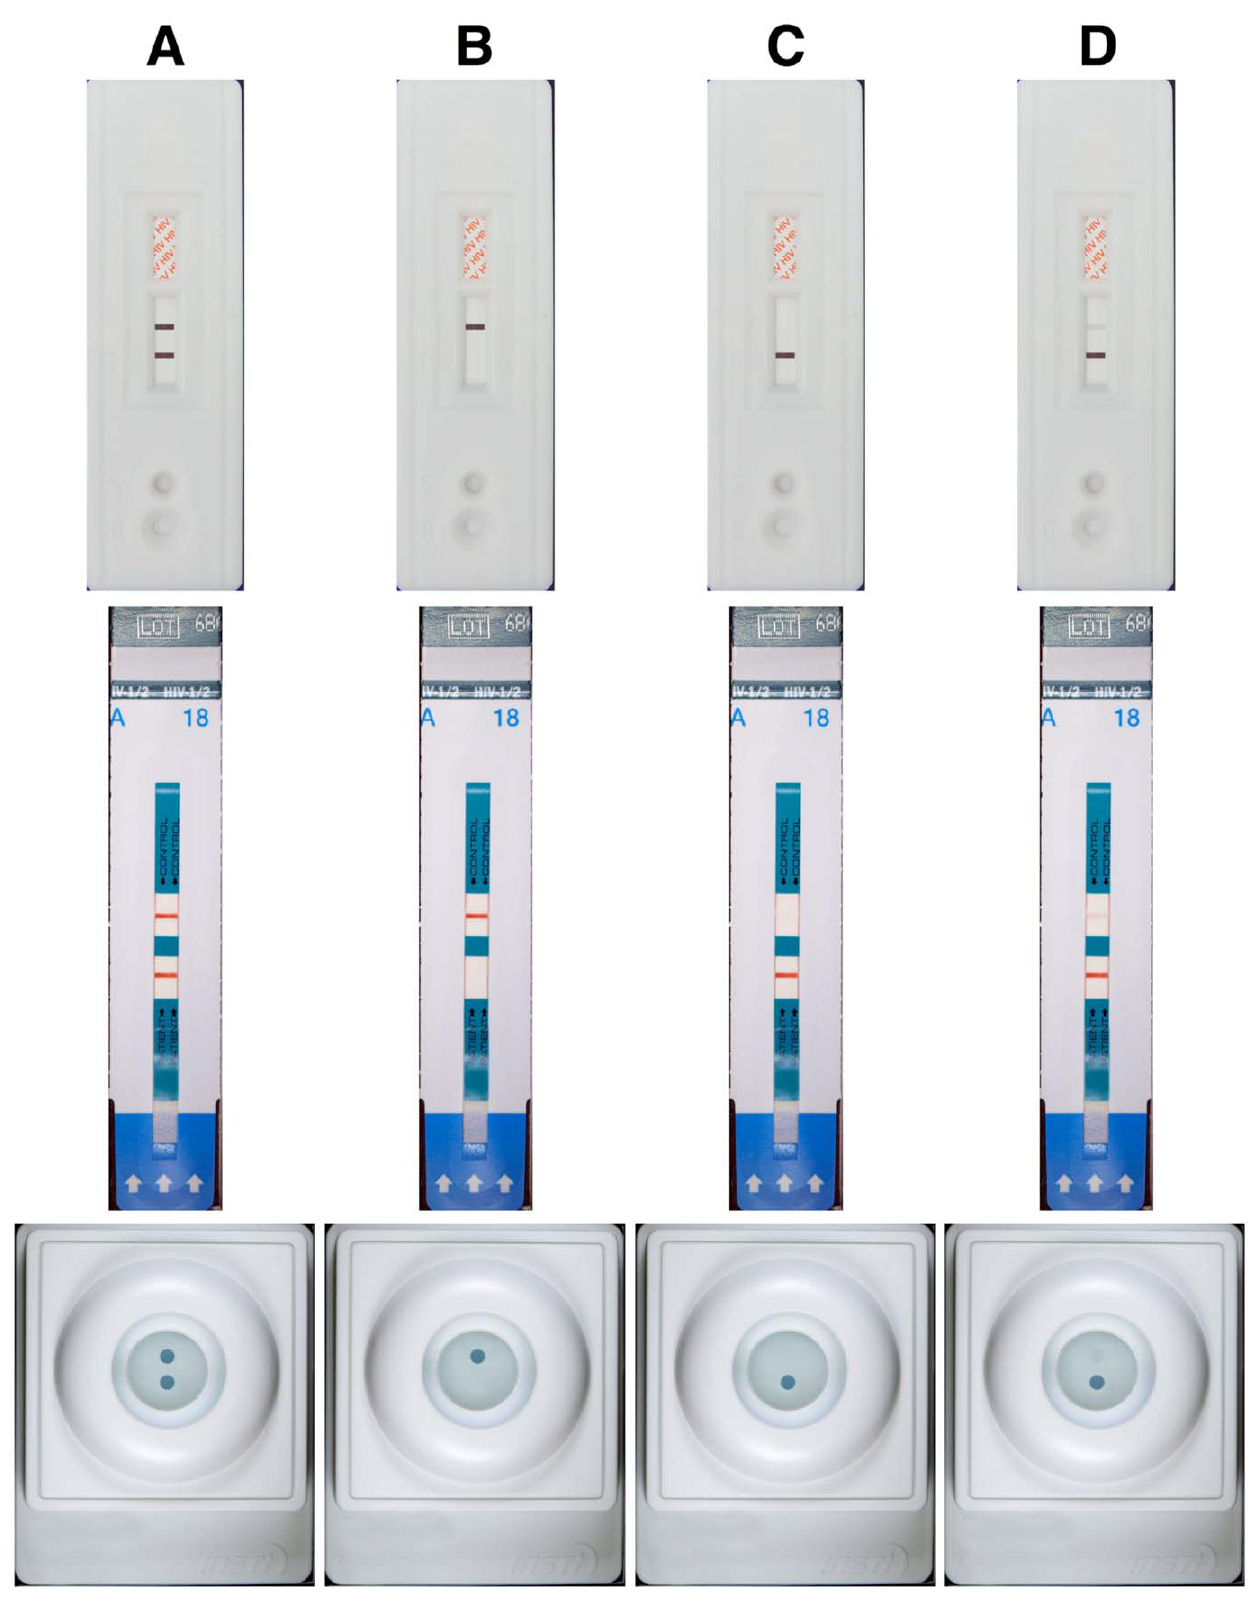
Figure 3. Possible types of result for two-line/dot HIV rapid diagnostic tests (RDTs). RDTs from top to bottom are: Advance Quality, Determine and Insti. Typical results for reactive (A), non-reactive (B) and invalid sample results (C) as shown in manufacturers’ instruction were considered "obvious". The results labeled D were considered "difficult" because of the presence of only a faint line/dot and because both lines/dots are not the same intensity.